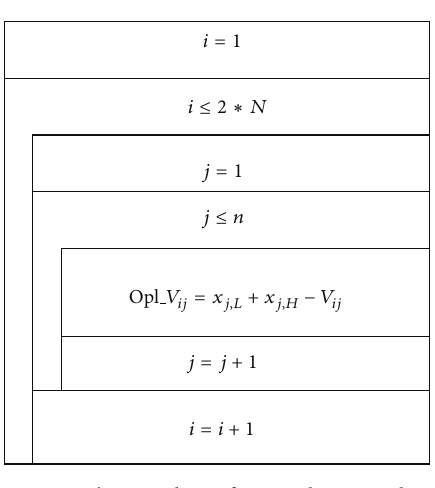
Figure 2: The 𝑁 - 𝑆 chart of reverse learning phase.